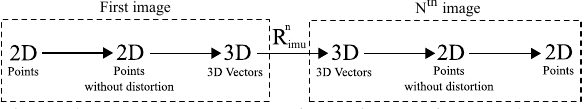
Figure 5. Successive steps to obtain the coordinates of corre- sponding location of pixel in other image. R n tion obtained by IMU between the first image and the N th image.